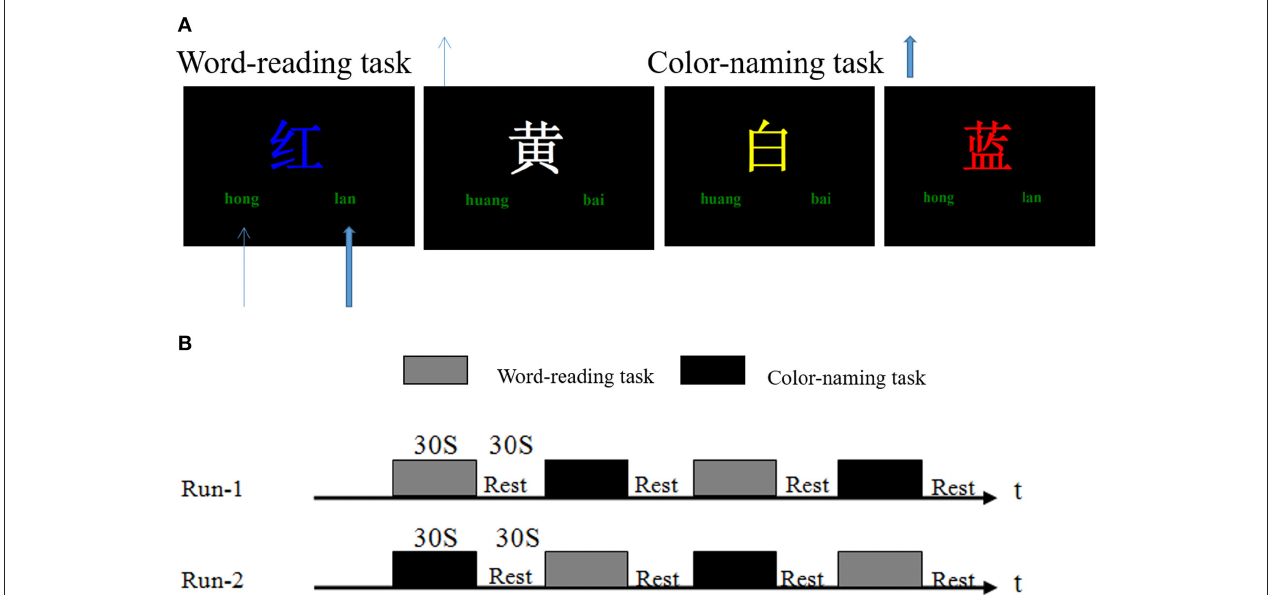
FIGURE 1 | Stroop task and fMRI experimental design. (A) Stroop task stimulus presentation. Different written colors of the Chinese characters such as “ 红 (red), 黄 (yellow), 蓝 (blue), and 白 (white)” were randomly presented on the computer screen. “Left click” and “right click” represented the Chinese characters and the color of the word, or the color and the Chinese characters (e.g., in the word reading task, the subjects should left click (“hong,” thin blue arrow), or otherwise right click (“lan,” wide blue arrow) during the color-naming task). (B) fMRI experimental design. Two scans were performed for each subject. The task blocks contained word-reading and color-naming tests; each lasting 30s. The baseline control block (Rest) lasted 30s, and only a fixation cross was